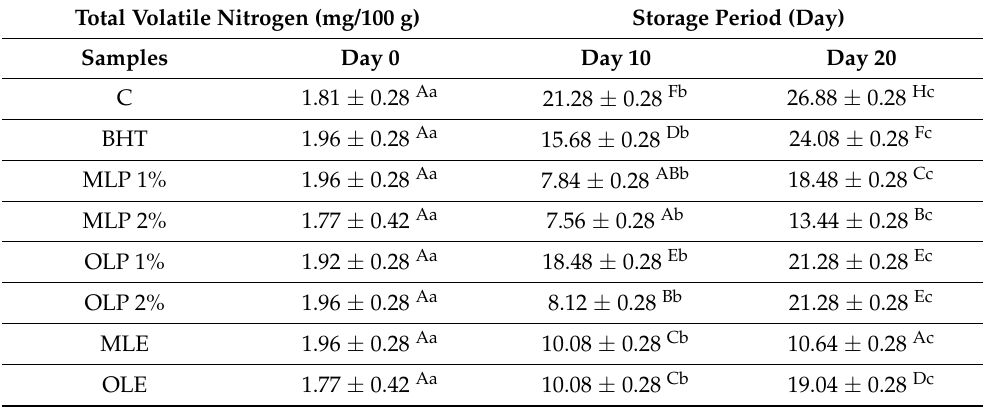
Table 3. Total volatile nitrogen (TVN) of chicken burgers during storage for 20 days, at 4 ◦